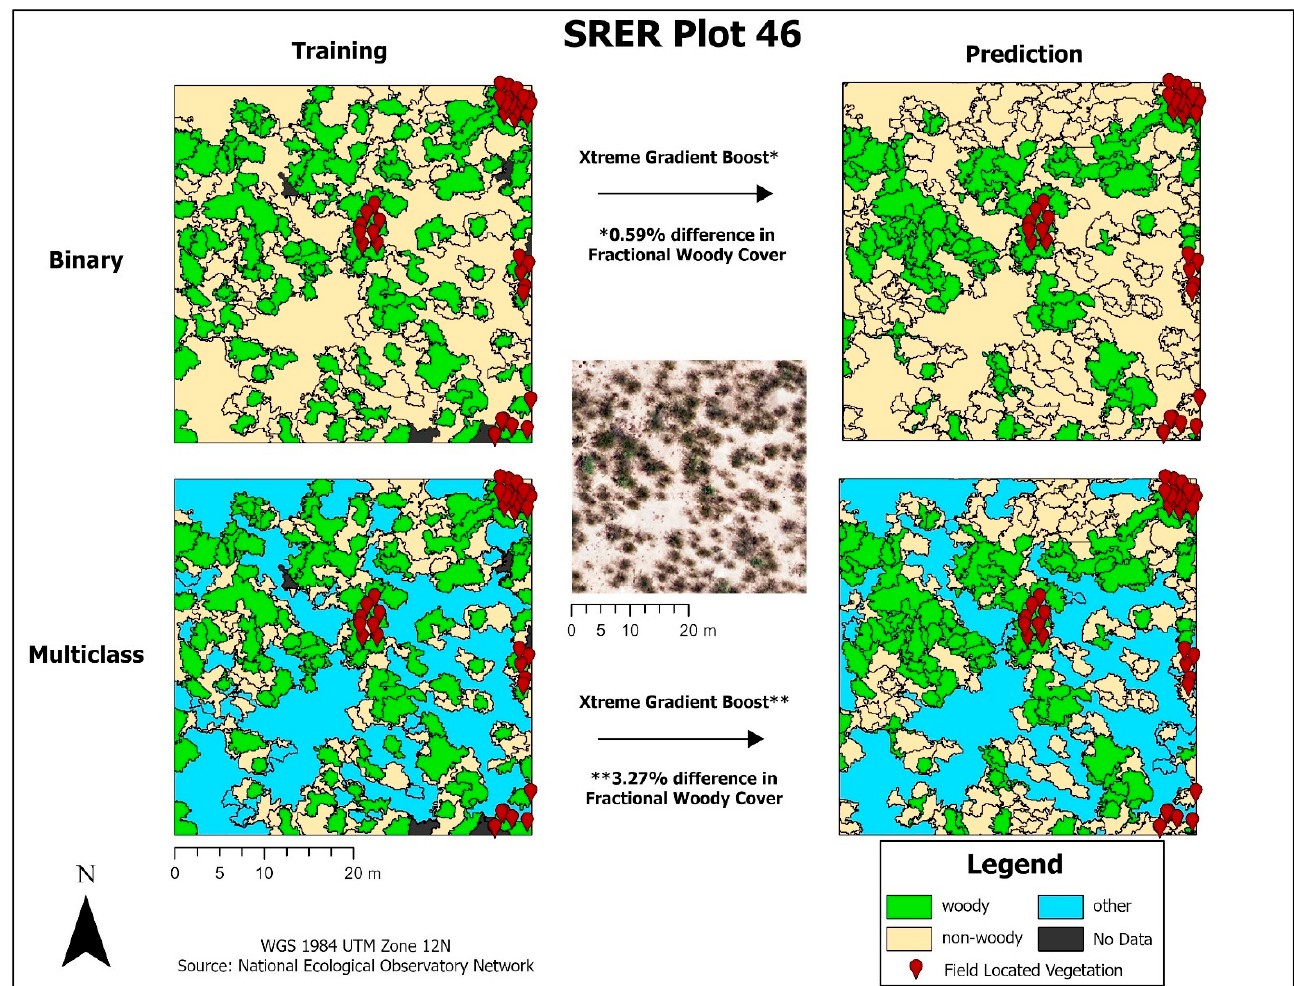
Figure 6. XGB predictions for Plot 46 under both binary and multiclass classification schemes. Despite slight differences in image segmentation, overall estimations of FWC are very similar between training and prediction methods, with slight overprediction of FWC indicated by positive dFWC values. Most differences in classification occur in polygons that appear less green in imagery, but field verification indicates live vegetation (polygons on the east and southeast border for example). This presents a possible limitation in AOP or model ability to determine live plant status with current sensor/data resolutions. The multiclass scheme appears to be classifying the less green, but still live vegetation as non-woody and the surrounding bare ground as other. Model predictions also seem to predict woody vegetation in more clustered groups compared to the training data which is more sporadic. This highlights human ability to discern small gaps in vegetation relative to the model. dFWC remained relatively low (0.59% for binary and 3.27% for multiclass) despite these differences.